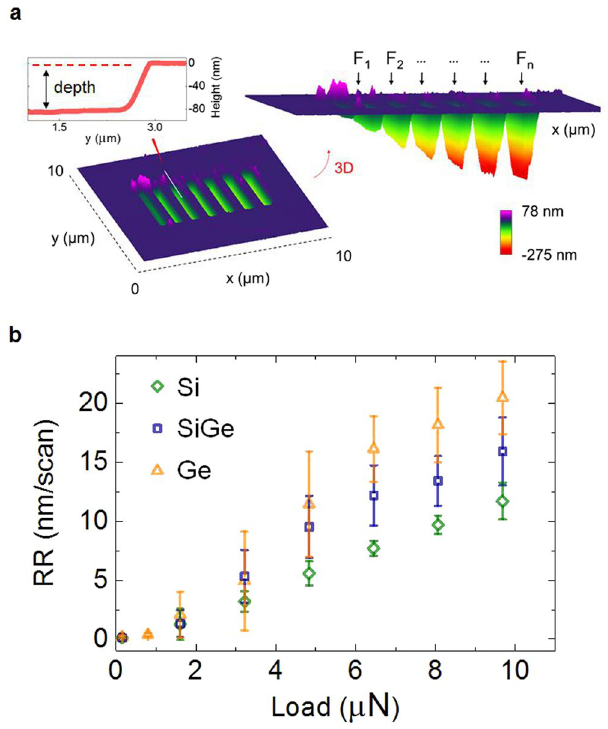
Figure 2. Experimental removal rate as a function of load forces. ( a ) Trench depths as seen by AFM topographical measurements across seven previously machined regions (size 4 µ m × 500 nm) with increasing load force (F 1 < F 2 … < F n ). (b ) Dependence of the removal rate on the tip load force for Si, SiGe and Ge for a diamond tip scanned in contact with the sample’s